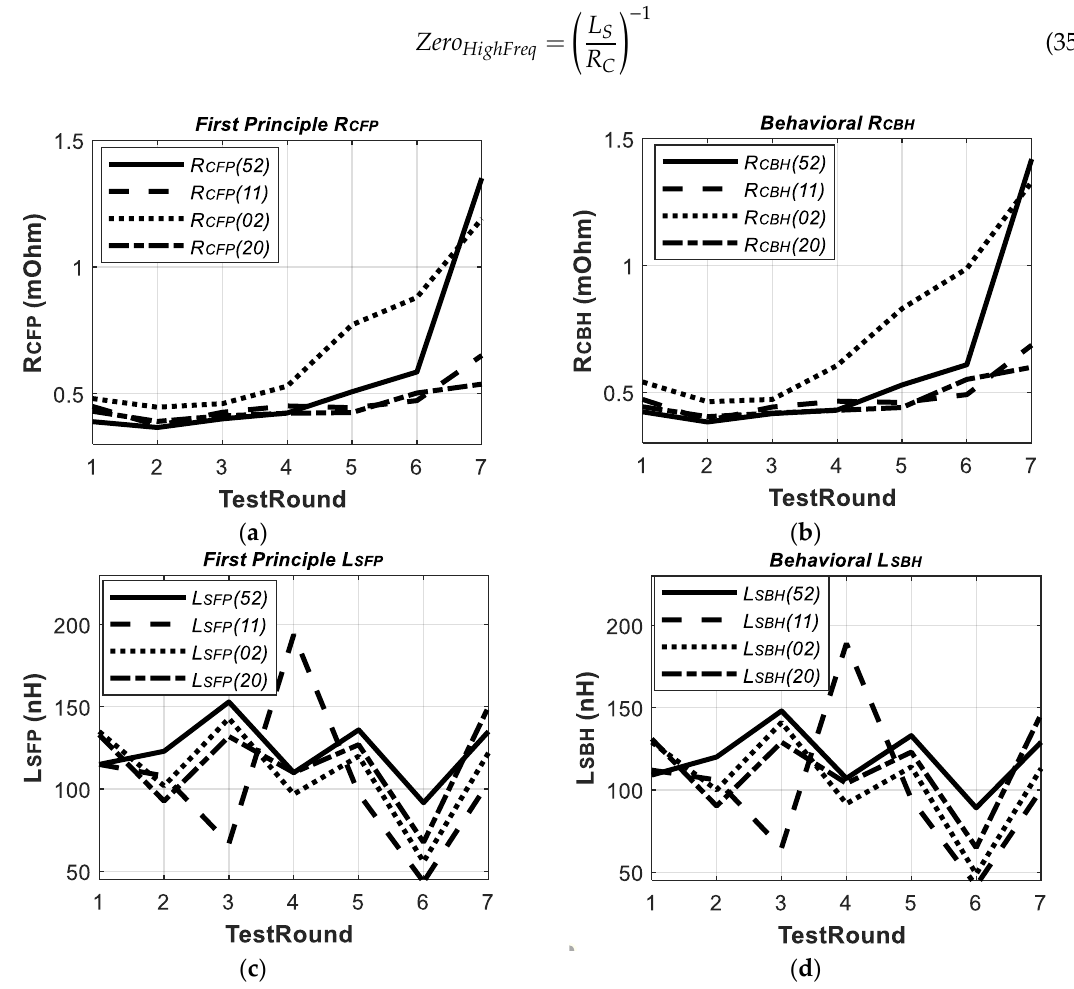
Figure 16. Elements values in linear circuits fitting for EIS: ( a ) R CFP in FPLC ACequ ; ( b ) R CBH in BHLC ACequ ; ( c ) L SFP in FPLC ACequ ; ( d ) L SBH in BHLC ACequ